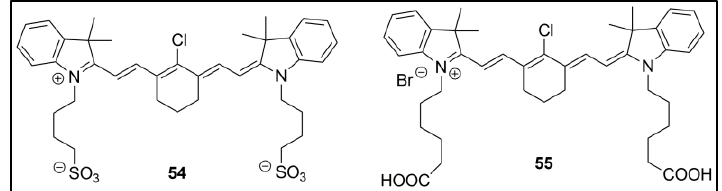
Figure 53. Structure of compounds 54 and 55